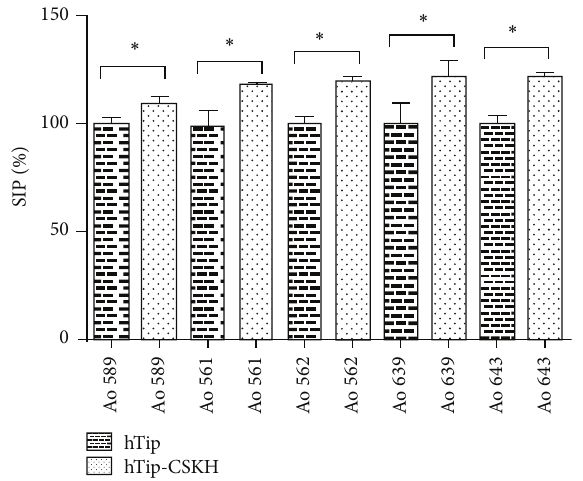
Figure 2: hTip-CSKH even induced a slight increase in prolifer- ation in PHA-P-stimulated Aotus nancymaae PBMC. Five Aotus nancymaae PBMC samples were treated with hTip and hTip-CSKH peptides (40 𝜇 M); after 1-hour incubation, 2 𝜇 g/mL PHA-P was added to the culture. [ 3H ] -thymidine incorporation was assessed after 72 h of culture. Student’s 𝑡 -test statistically significant values ( 𝑝 < 0.05 ) are marked with asterisk ( ∗ ).